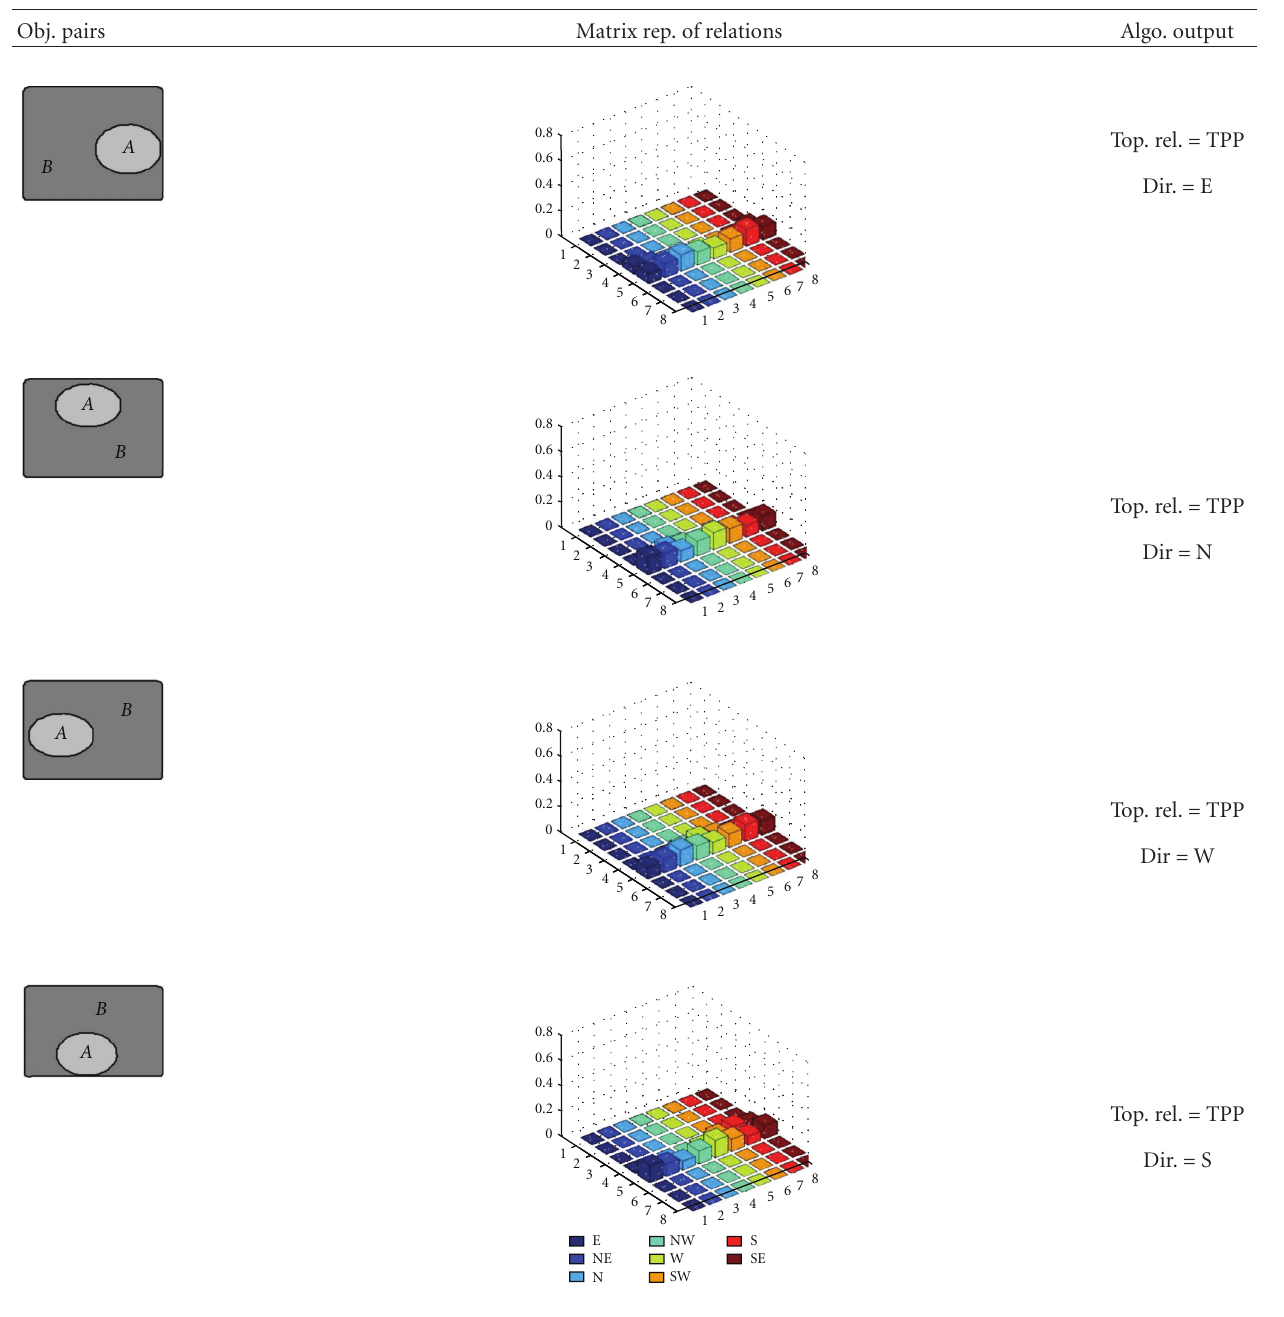
Table 5: Object pairs with TPP topological and their directional relations. Obj. pairs Matrix rep. of relations Algo. output